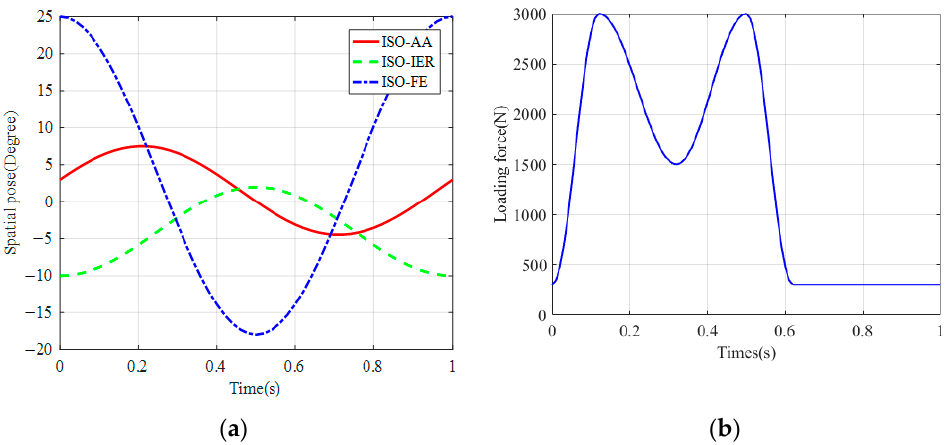
Figure 4. Loading and displacement parameters for wear-testing machines. ( a ) Motion curves; ( b ) Loading force.